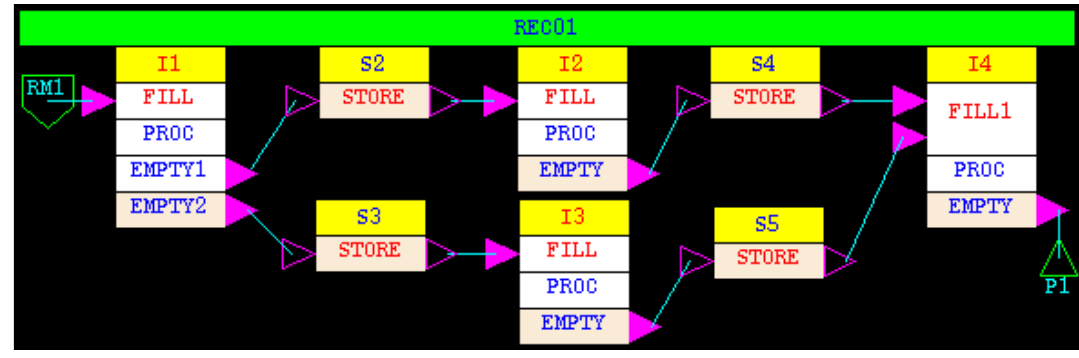
Figure 2. Recipe network for Example 1.